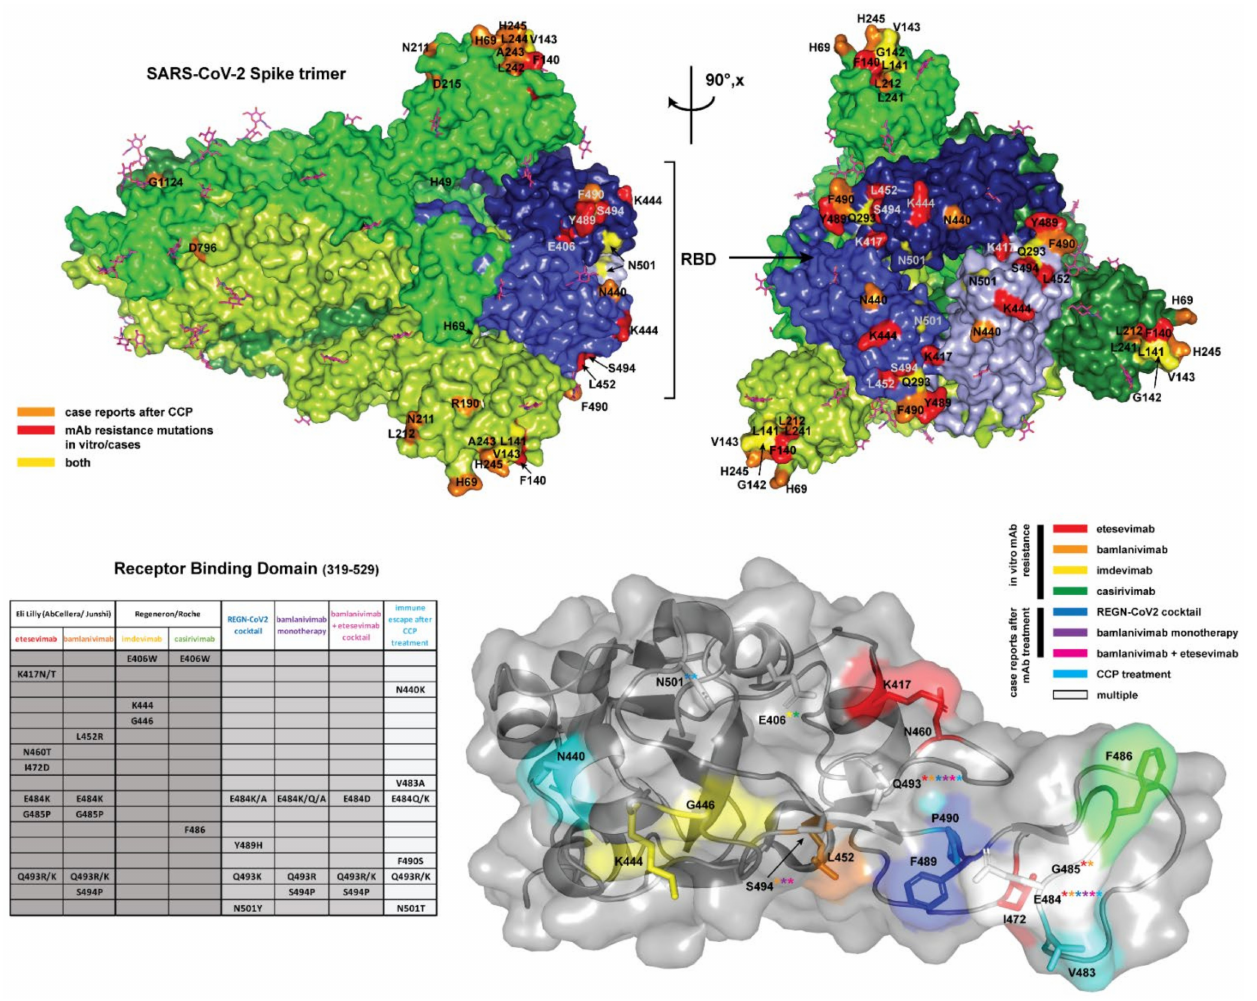
Figure 2. ( Top panel ) The full SARS-CoV-2 S (spike) glycoprotein homotrimer (PDBID 6VXX) [16] in the prefusion conformation is shown in surface representation, with each spike monomer colored a different shade of green. N-linked glycosylations which were resolved in the cryo-EM map in this structure (16/22 sequons per protomer) are displayed as magenta sticks. The receptor binding domains (RBDs), in the closed state, are highlighted in 3 shades of blue corresponding to the shade of the corresponding